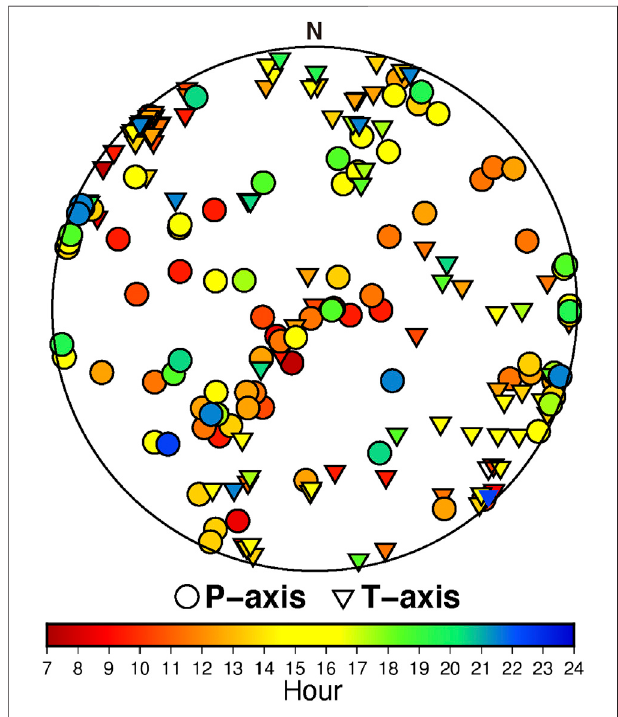
FIGURE 11 | Distribution of the tension (T)-axes (inverted colored triangles)andpressure(P)-axes(coloredcircles)ofthefocalmechanismsinan equal-area lower-hemisphere projection of the focal sphere. The colors indicate the occurrence time as in Figure 7 .